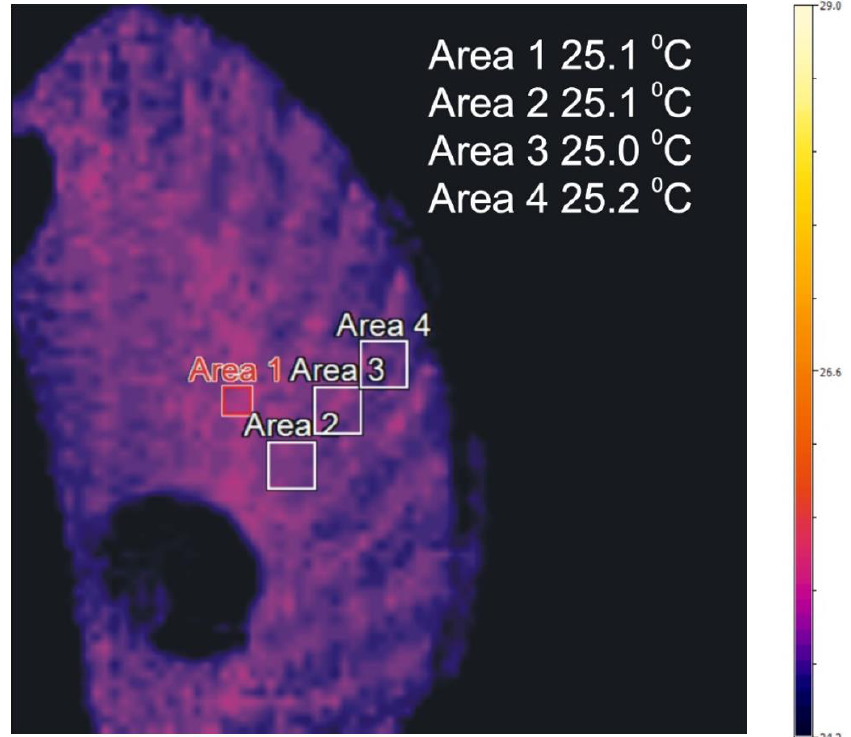
Figure 13. Distribution of temperature in the face gear, unloaded, in the reference temperature present the distribution of temperature for selected measurements from Table 3.